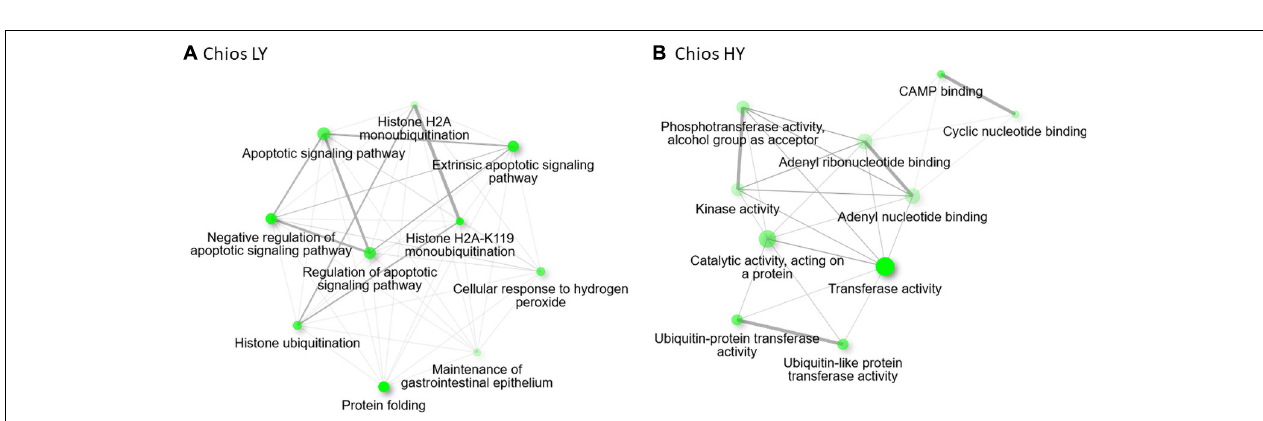
FIGURE 5 | Enriched gene ontology terms based on the annotated differentially expressed genes, visualized as a network, for (A) Chios low yielding group and (B) Chios high yield animals.